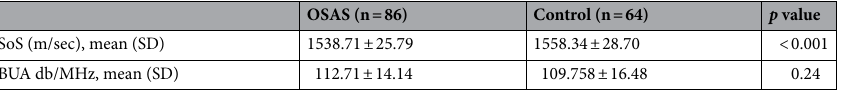
Table 2. Comparison of the parameters of QUS of the calcaneus (speed of sound (SoS) and broadband ultrasound attenuation (BUA) in children with OSAS to healthy control. Remarks : independent t-test was used to investigate the mean differences for BUA and SOS (normal distribution based on skewness and kurtosis in between − 2 and 2). Equal variances were assumed ( p > 0.05). SD standard deviation.